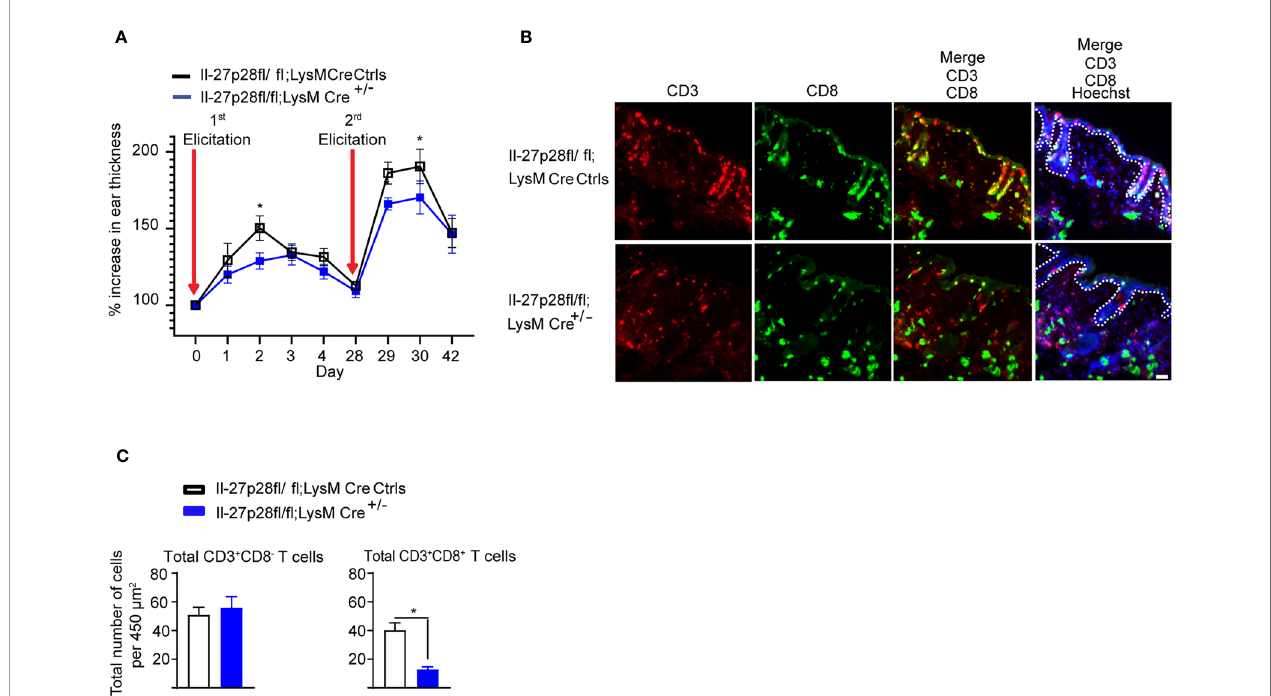
FIGURE 4 | MAC-derived IL-27p28 mediates CHS in fl ammation and maintenance of dermal T cell numbers. (A) Il-27p28 fl / fl ;LysMCre +/- and Il-27p28 fl / fl ;LysMCre -/- control mice (Ctrls) were sensitized and elicited with DNFB 2 times. Ear swelling was measured daily and is depicted as mean ± SEM from at least 5 mice per group, *p < 0.05 (ANOVA test followed by least-signi fi cant differences multi-comparison (LSD) test). (B) Representative immuno fl uorescence staining showing CD3 (red), CD8 (green), and Hoechst (blue) in DNFB-treated back skin from Il-27p28 fl / fl ;LysMCre +/- and Il-27p28 fl / fl ;LysMCre control mice (Ctrls). Data are representative of 3 mice per group. Original magni fi cation x200 with scale bars 50 µm. White dashed lines mark the epidermal-dermal junction. (C) Analysis of total numbers of CD3 + CD8 - and CD3 + CD8 + T cells of mouse back skin. Data depicted as mean ± SEM from 3 mice per group using at least 3 microscopic views (area = 450 µm 2 ), unpaired Student ’ s t test, *p <